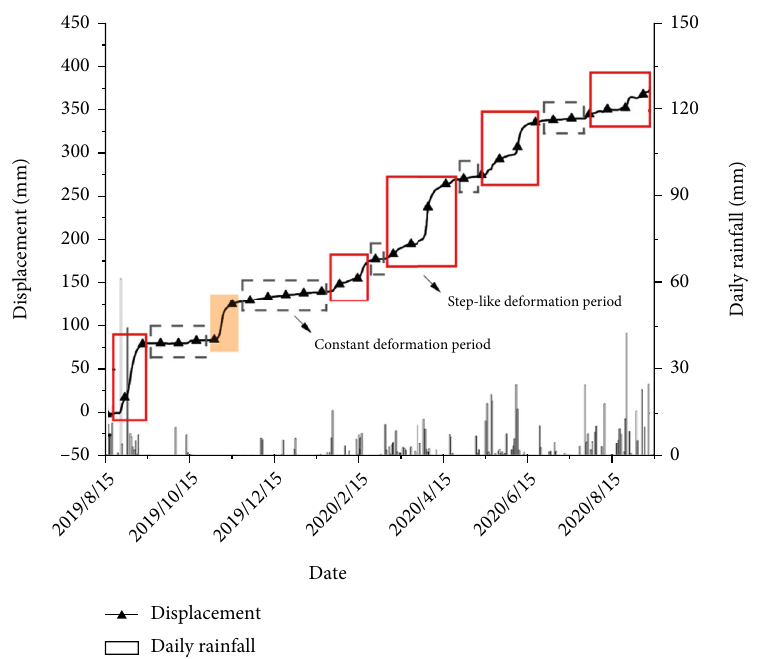
Figure 6: Relationship curve between rainfall and deep horizontal displacement at 12 m depth below the surface at point A in the study